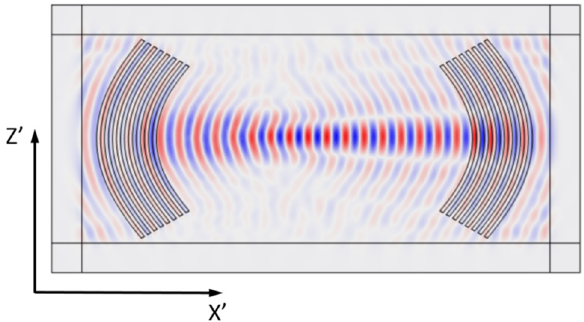
Figure 5. Distribution of the mechanical displacement component U Z’ in the direction of wave propagation X’ for SH 0 wave in YX LiNbO 3 at f = 3.7 MHz excited by electrodes with a curvature that takes into account the anisotropy in the angle φ .